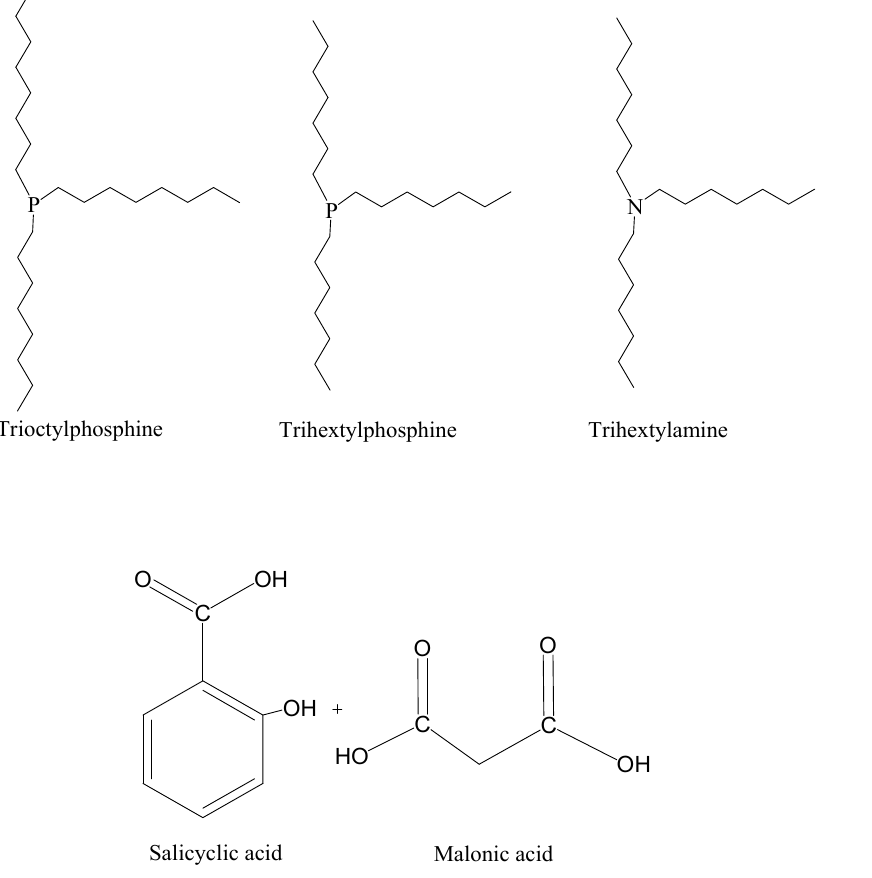
Figure 1. HBA and HBD of prepared DESs. Table 1. DESs precursors, preparation ratios, and properties. Table 1. DESs precursors, preparation ratios, and